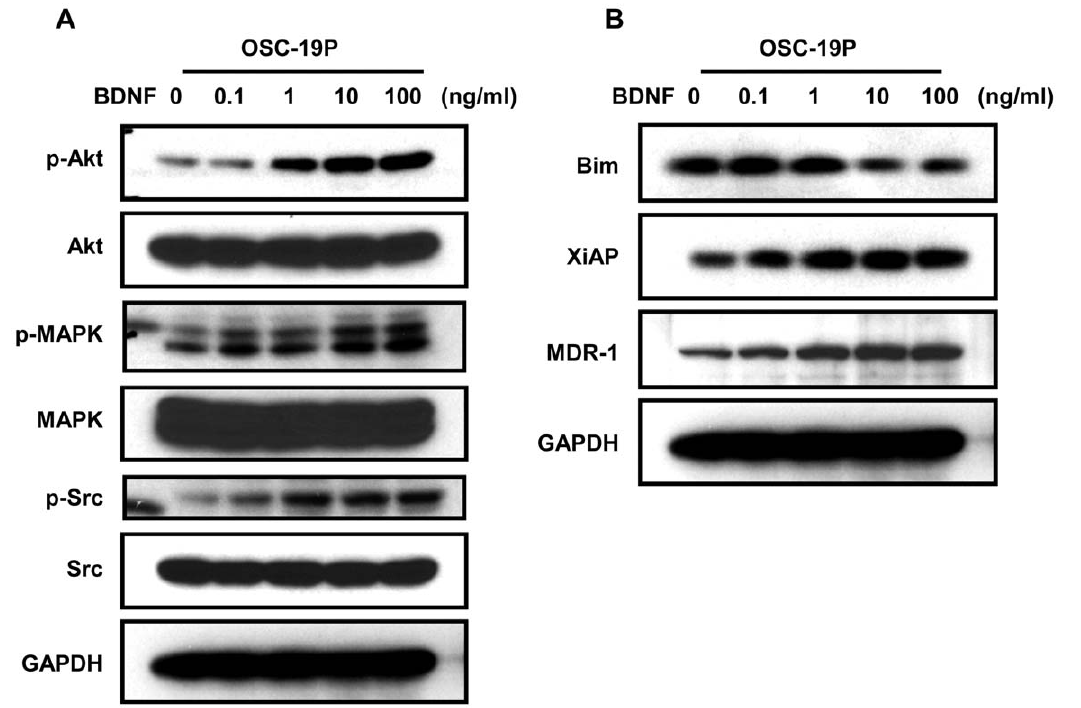
Figure 4. BDNF induces signals and modulates MDR1, Bim, and XiAP in CDDP sensitive cells. A . Dose-dependent up-regulation of intracellular signals, Akt, Src, and MAPK in OSC-19P. The culture reaches , 80% confluent, cells were starved for overnight with medium without serum. Lysate was collect after 24 hour treatment with 100 ng/ml BDNF and separated with SDS-PAGE gel and membrane was incubated with indicated antibodies. B . Western blot analysis of XiAP, Bim, and MDR1 following treatment with various concentration of BDNF for 24 hours (0.1, 1, 10, and 100 ng/ml, respectively).